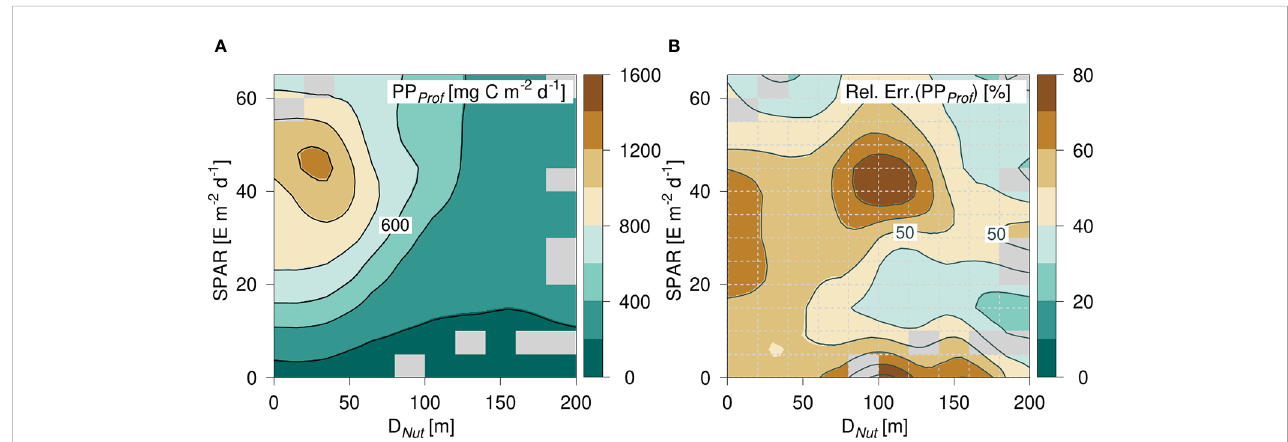
FIGURE 6 (A) PP-diagram of average primary production (PP) calculated from PP Prof and (B) the relative error de fi ned by s (PP)/PP in each cell (cells are shown with gray dashed lines). Grid cells with less than 5 data points are fi lled